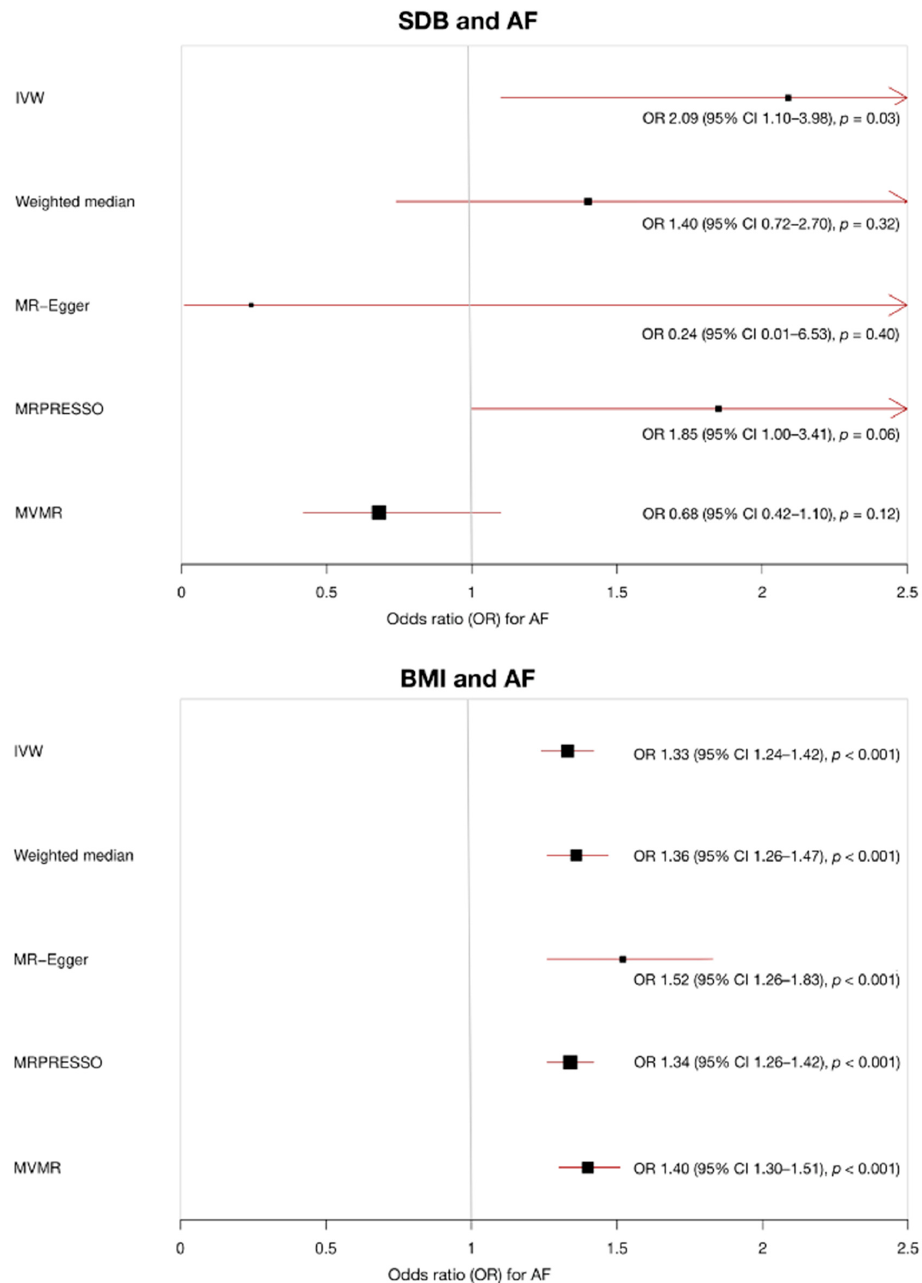
Figure 2. Mendelian randomisation (MR) results for the association of sleep-disordered breathing (SDB) and body mass index (BMI) with atrial fibrillation (AF). When SDB is the exposure (units of log odds ratio snoring liability), multivariable MR analysis adjusts for genetically predicted BMI. When BMI is the exposure (units of kg/m 2 ), multivariable MR analysis adjusts for genetically pre- dicted SDB.